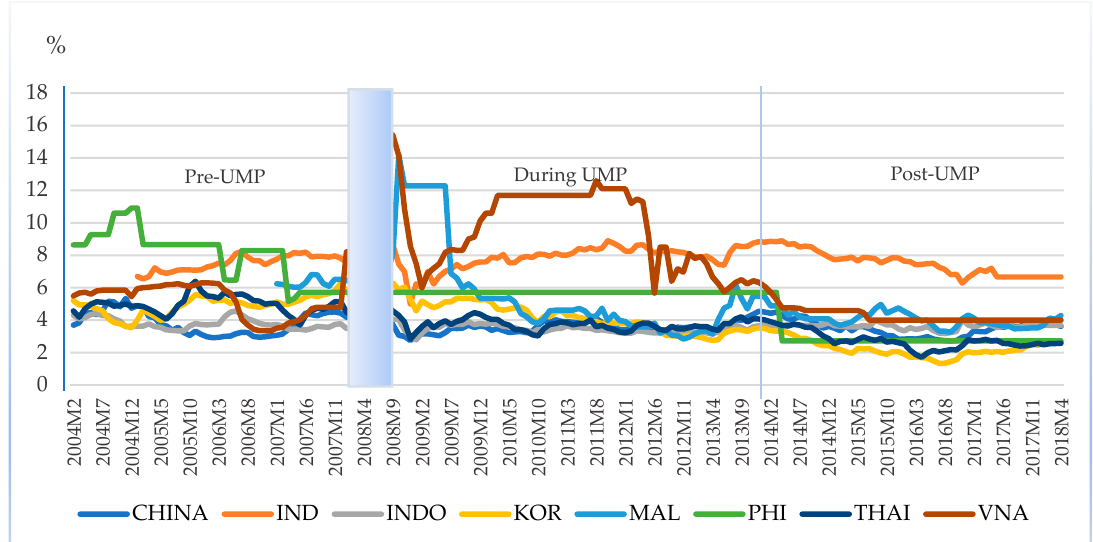
Figure 4. Long-term interest rates in Asian developing countries for the whole period (source: Bloomberg, national sources). CHINA = China; IND = India; INDO = Indonesia; KOR = Korea; MAL = Malaysia; PHI = Philippines; THAI = Thailand; VNA = Vietnam. Crisis period. One US Dollar